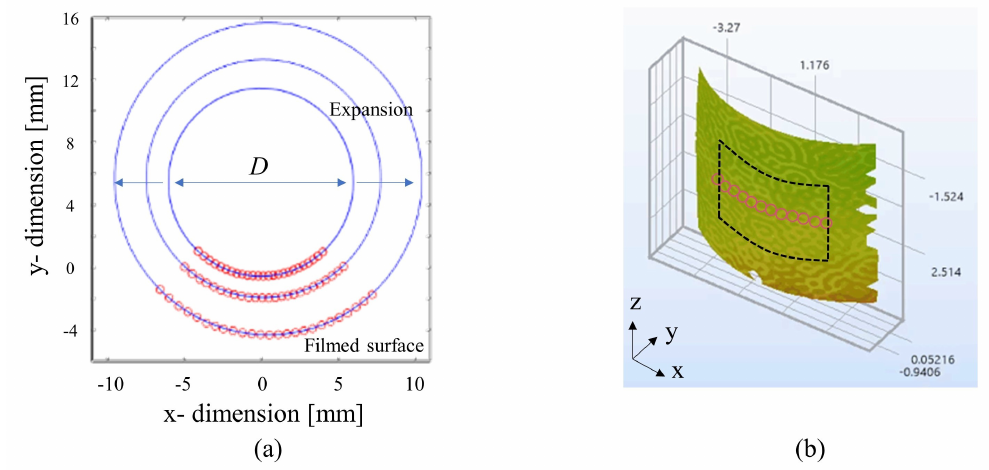
Figure 4. Filmed deformed specimen surface represented by ( a ) the evolution of the cross − sectional surface area with the fit of circle onto horizontal mid − plane and ( b ) vertical Hencky strain post- processed by 3D stereo − DIC system.